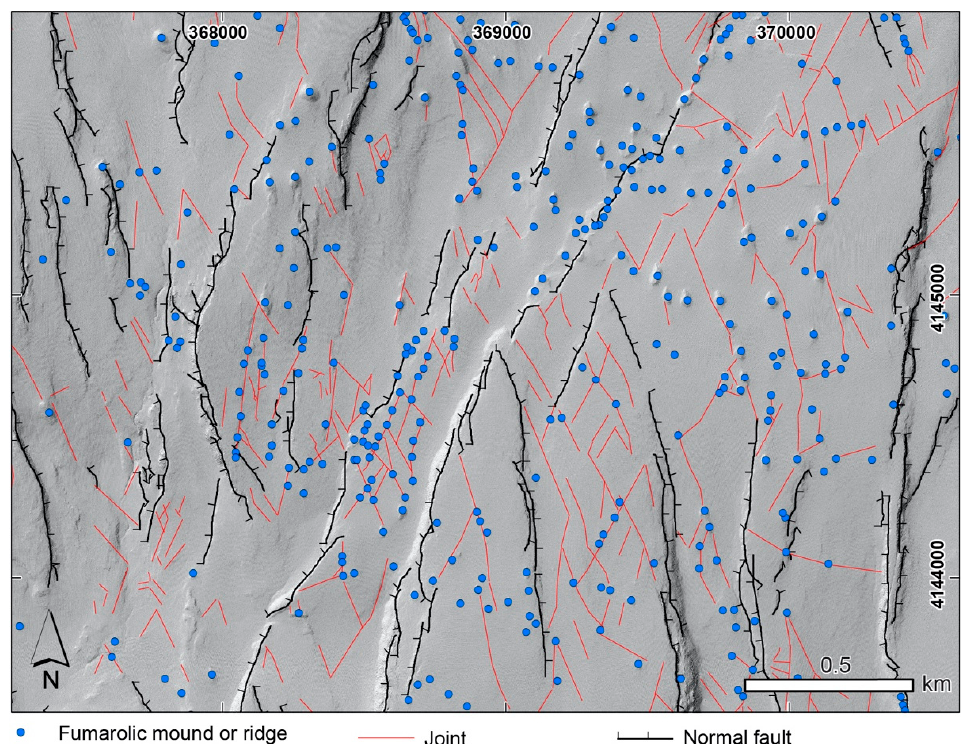
Figure 9. Hillshade map in a region with a high density of fumarolic mounds and ridges (blue dots) showing the geometry of the fracture network consisting of normal faults (mapped in black) and joints (mapped in red). UTM coordinates are given in meters for UTM zone 11N.